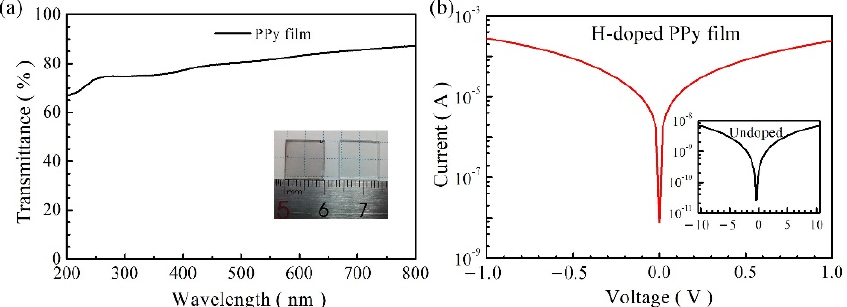
Figure 4. ( a ) UV-Visible optical transmission spectrum of PPy film. ( b ) IV curve of PPy film. The inset is the IV curve of undoped PPy film. Table 1. The conductivity values of different oxide and monomer ratios. Samples